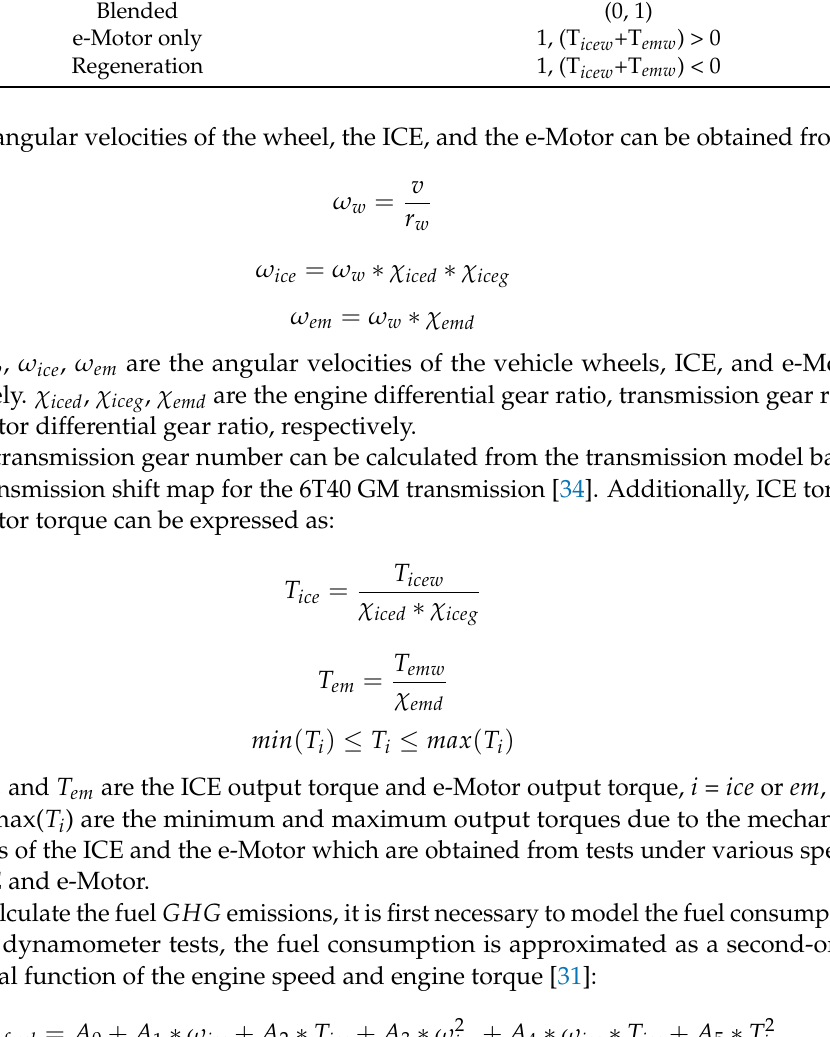
Table 2. Operation modes and torque split value. Operation Mode Torque Split Value Charging